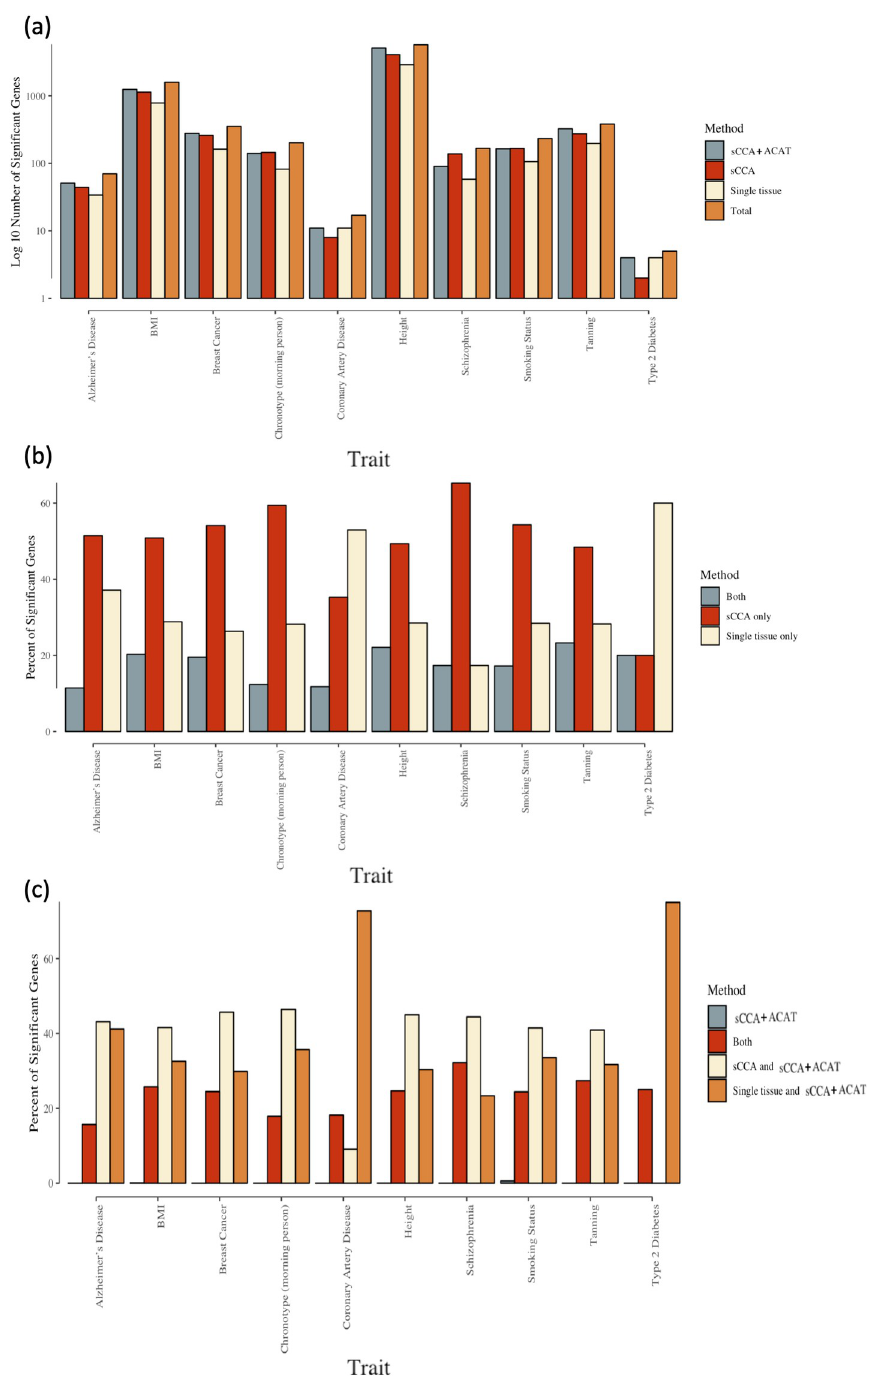
Fig 6. (a) Number of significant genes identified by ACAT combined test, sCCA-TWAS, TWAS using single tissue GTEx data and the total number of significant genes identified by all three methods. Different phenotypes are arranged along the x-axis and the number of significant genes identified by ACAT combined test, sCCA+TWAS, TWAS using single-tissue GTEx data and the total number of significant genes identified by all three methods are shown in the y-axis on log 10 scale. The information about the phenotype are provided in Table 1. sCCA+ACAT: combining 3 sCCA-features and 22 single-tissue tests with ACAT; sCCA: combining top 3 sCCA-features tests using a Bonferroni correction; Single Tissue: combining 22 single-tissue TWAS statistics using Bonferroni. (b) Percentage of significant associations identified by both single tissue TWAS and sCCA TWAS, by only sCCA-TWAS, and